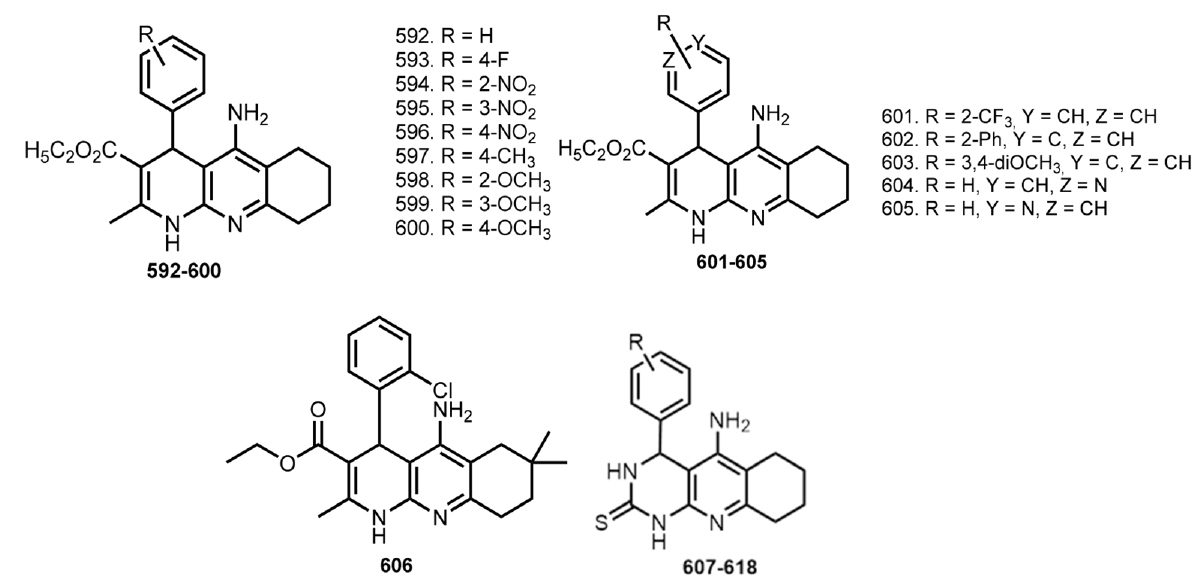
Figure 23. THA–nimodipine hybrids 592 – 600 , 601 – 605 [94,95], THA–dihydropyridine hybrid 606 [97], THA ‐ dihydropyirimidine ‐ thione hybrids 607 – 618 [98].